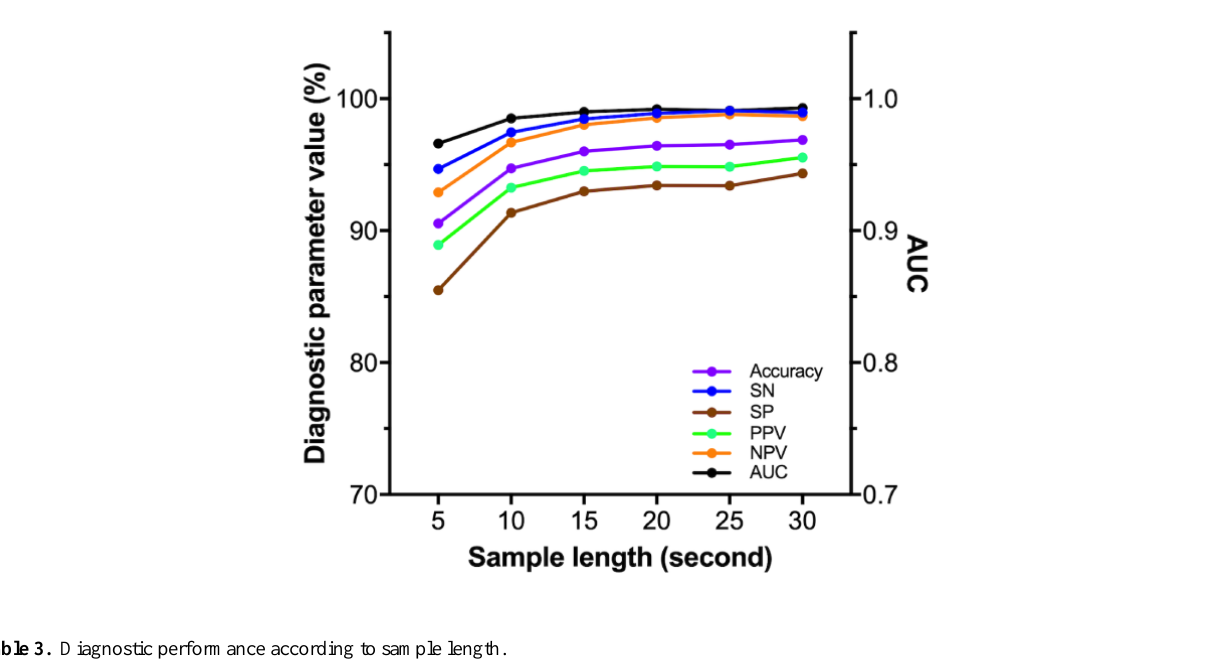
Figure 3. The diagnostic performance of CardioTracker according to sample length. In general, longer lengths of photoplethysmography samples had higher diagnostic performances. AUC: area under the curve, NPV: negative-predictive value, PPV: positive-predictive value, SN: sensitivity, SP: specificity.